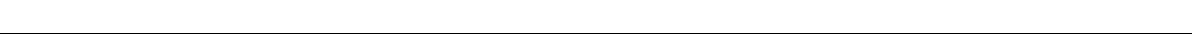
Fig. 6 Designability and applications of PNTs. a Structures of seven functionalized APOs. b AFM height image of one PNT assembled from CD-APO2 (scale bar, 150 nm); the insert is the height measurement showing the PNT height of about 12.2 nm. c TEM image of one PNT assembled from CD-APO2 (scale bar, 20 nm). d AFM height image of PNTs assembled from RGDG-APO2 (scale bar, 200 nm). e X-ray diffraction (XRD) data of PNTs assembled from APO2 (magenta), CE-APO2 (blue), DOP-APO2 (black), SSYA-APO2 (green), CD-APO2 (orange), or RGDG-APO2 (cyan); all of these PNTs show similar XRD peaks, indicating they all have similar structures. f UV/Vis spectra showing the removal of 4-aminoazbenzene (azo) from water. Red line represents azo-contaminated water; black line represents the CD-APO2-PNT decontaminated water. g – i Optical images (scale bar, 50 μ m) of A549 cancer cells absorbed on the RGDG-APO2-PNT-treated glass slide ( g ), APO2-PNT-treated glass slide ( h ), and on the bare glass slide ( i ). j The chart shows that the cell density of RGDG-APO2-PNT-treated glass slide is dramatically higher than those of control slides. k , l Fluorescent images showing the cellular uptake of sonication-cut-PNTs (in red color) co-assembled from APO2, RGDG-APO2, and Rb-APO2 with a molar ratio of 8:1:1 (scale bar, 8.0 μ m) ( k ) and from APO2 and Rb-APO2 with a molar ratio of 9:1 (scale bar, 5.0 μ m) ( l ), followed by staining with cytoskeleton actin (green) and DAPI (blue); the signi fi cantly higher density of red spots observed in Fig. 6k indicates that RGD-containing PNTs exhibited an enhanced cellular adhesion and uptake within A549 live